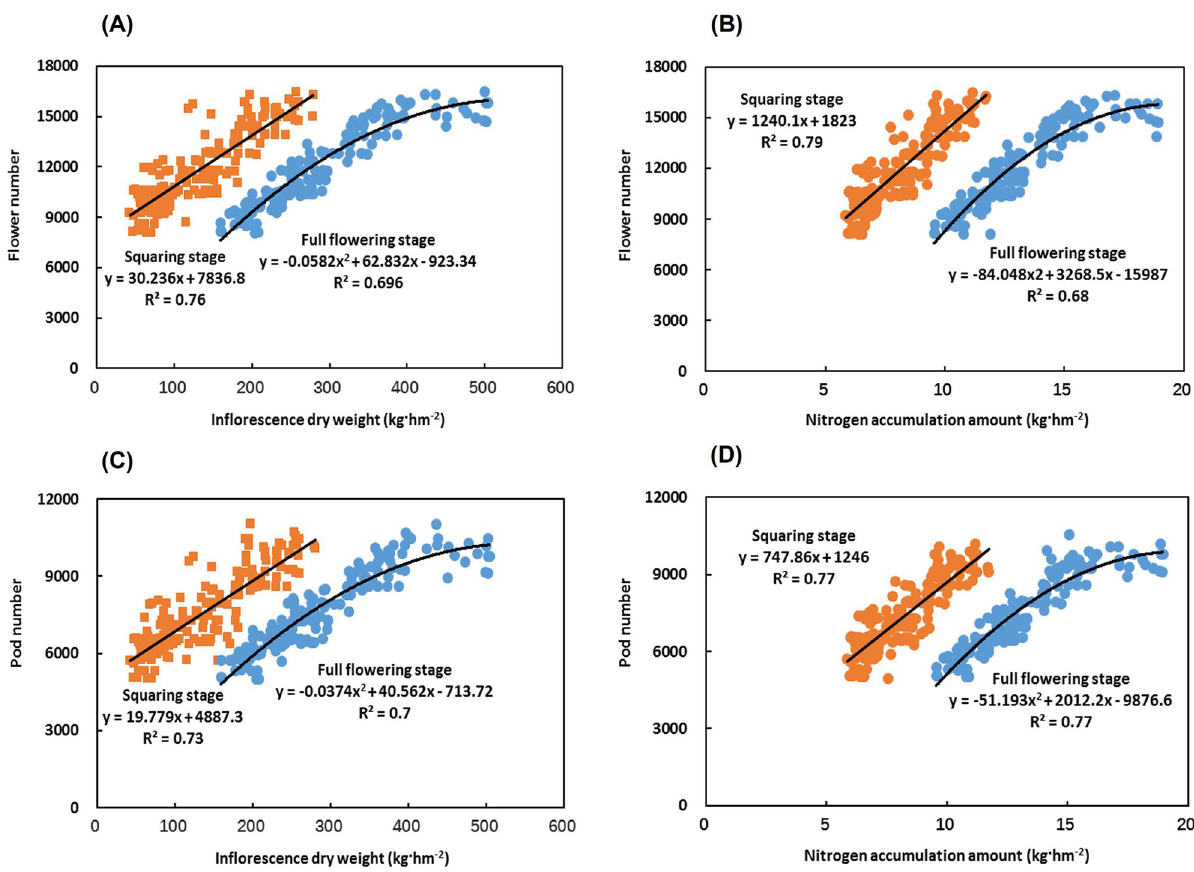
Fig 3. Relationship between the dry matter and nitrogen accumulation in the inflorescence organs of Chinese milk vetch and the number of flowers and pods. (A) Relationship between flower number and inflorescence dry weight of Chinese milk vetch (n = 180). (B) Relationship between flower number and inflorescence nitrogen accumulation in Chinese milk vetch (n = 180). (C) Relationship between pod number and inflorescence dry weight of Chinese milk vetch (n = 180). (D) Relationship between pod number and inflorescence nitrogen accumulation in Chinese milk vetch (n = 180). Orange symbols represent the squaring stage, and blue symbols represent the full flowering stage. All the experiments are shown.